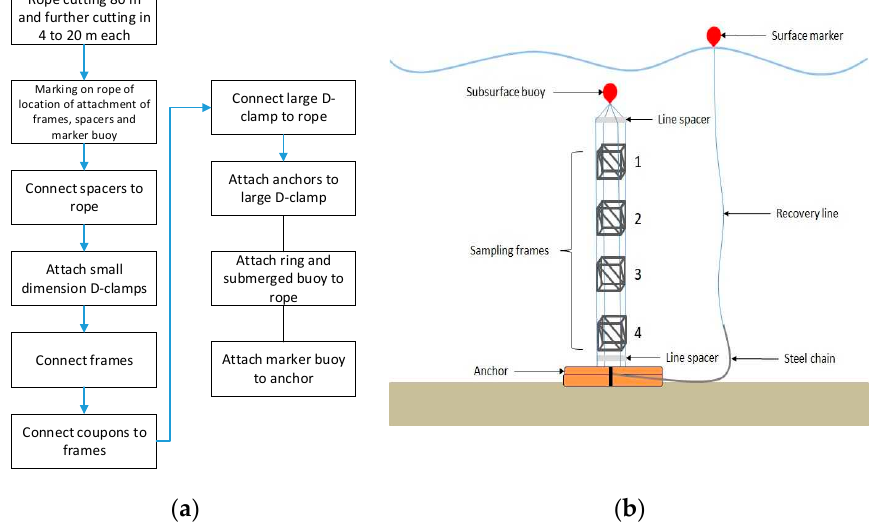
Figure 4. ( a ) Array assembly up flowchart; ( b ) schematic of assembly.